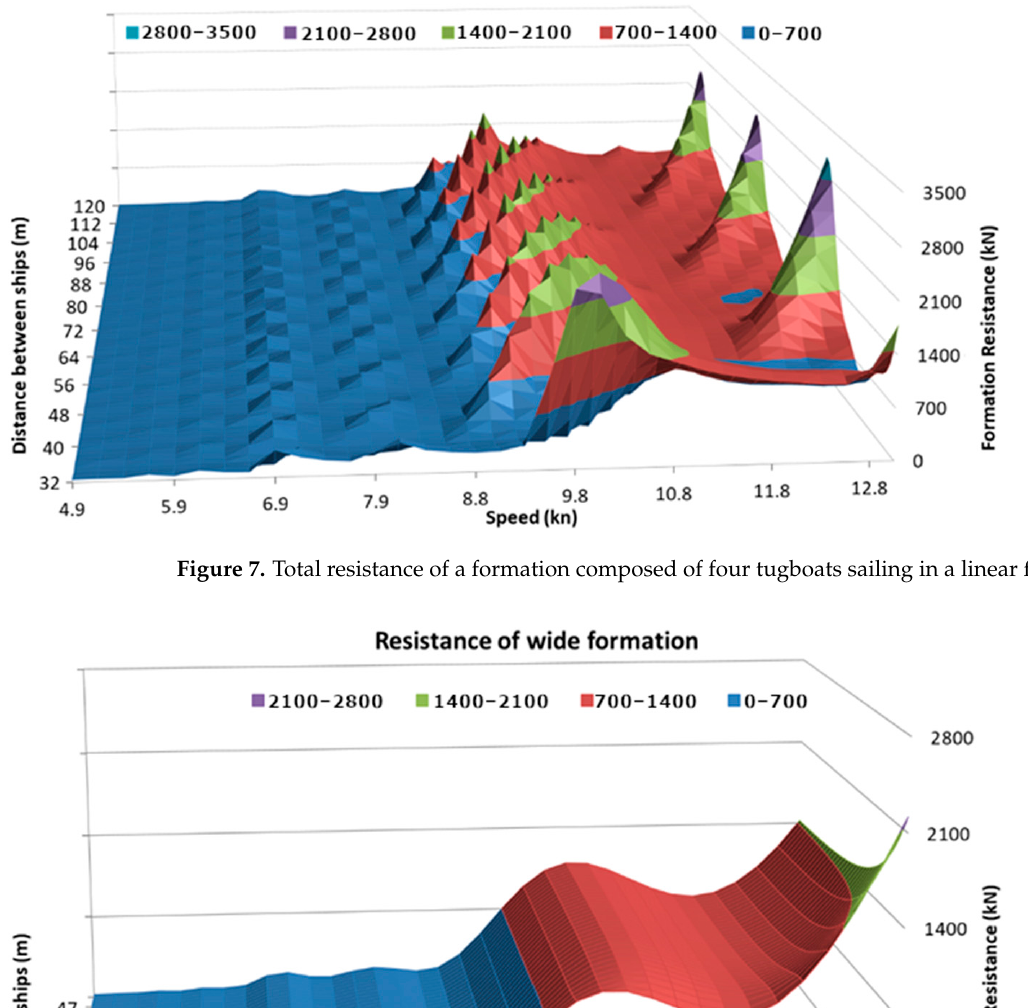
Figure 9. Total resistance of a formation consisting of four tugboats sailing in an echelon formation with an angle of 30°. Figure 10. Total resistance of a formation consisting of four tugboats sailing in an echelon for- mation with an angle of 45°.